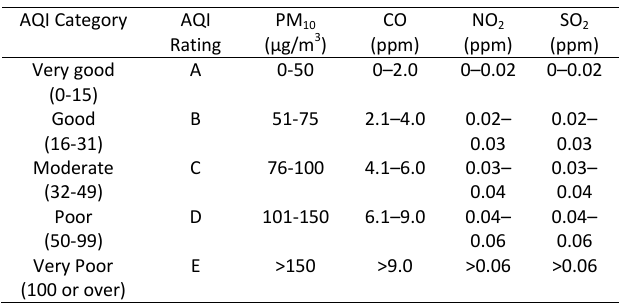
Table 1: Air quality index of air pollutants criteria